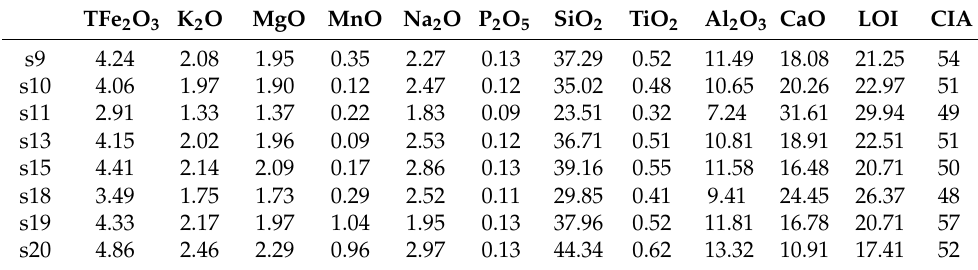
Table 2. Major element composition (%) and chemical index of alteration (CIA) of surface sediment samples in the southwestern Xisha Uplift, SCS.